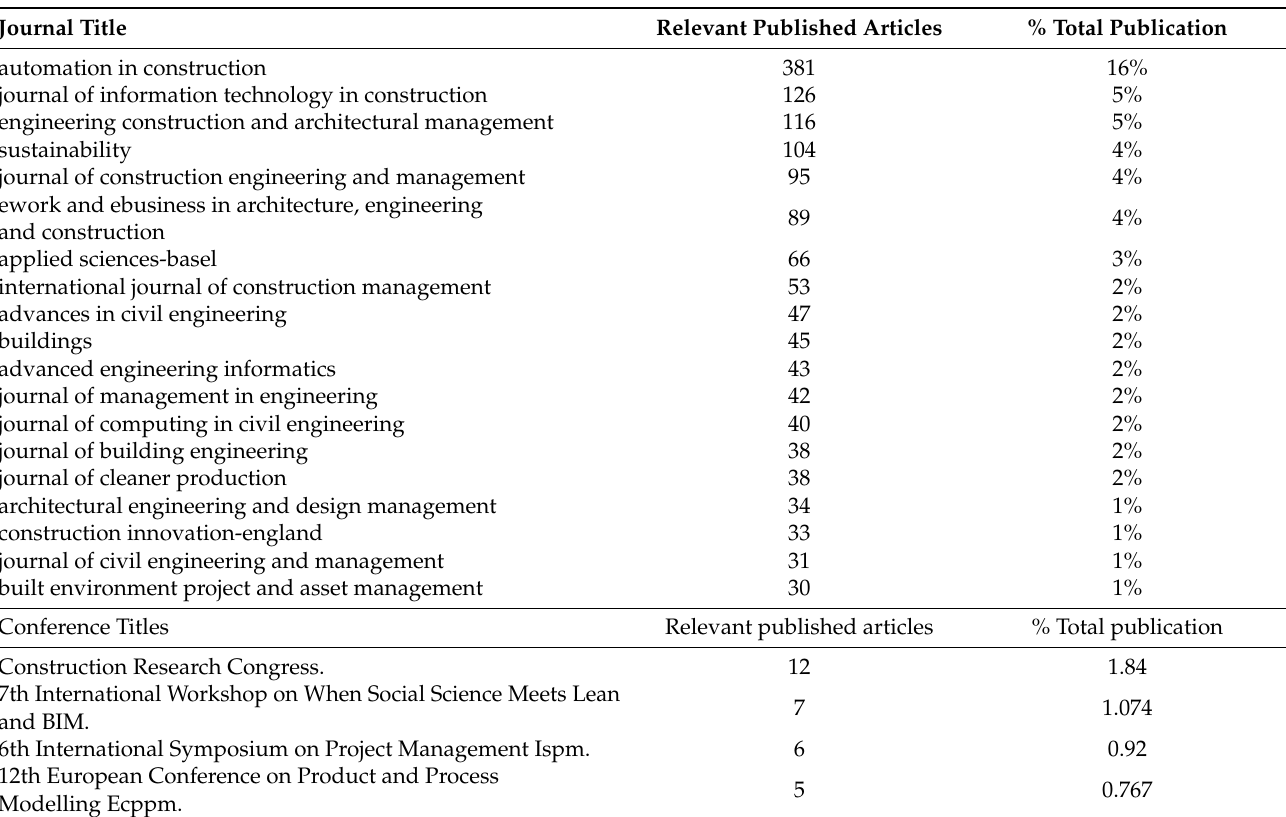
Figure 8. Journal co-citations network. Table 2. Top sources of academic documents of building information